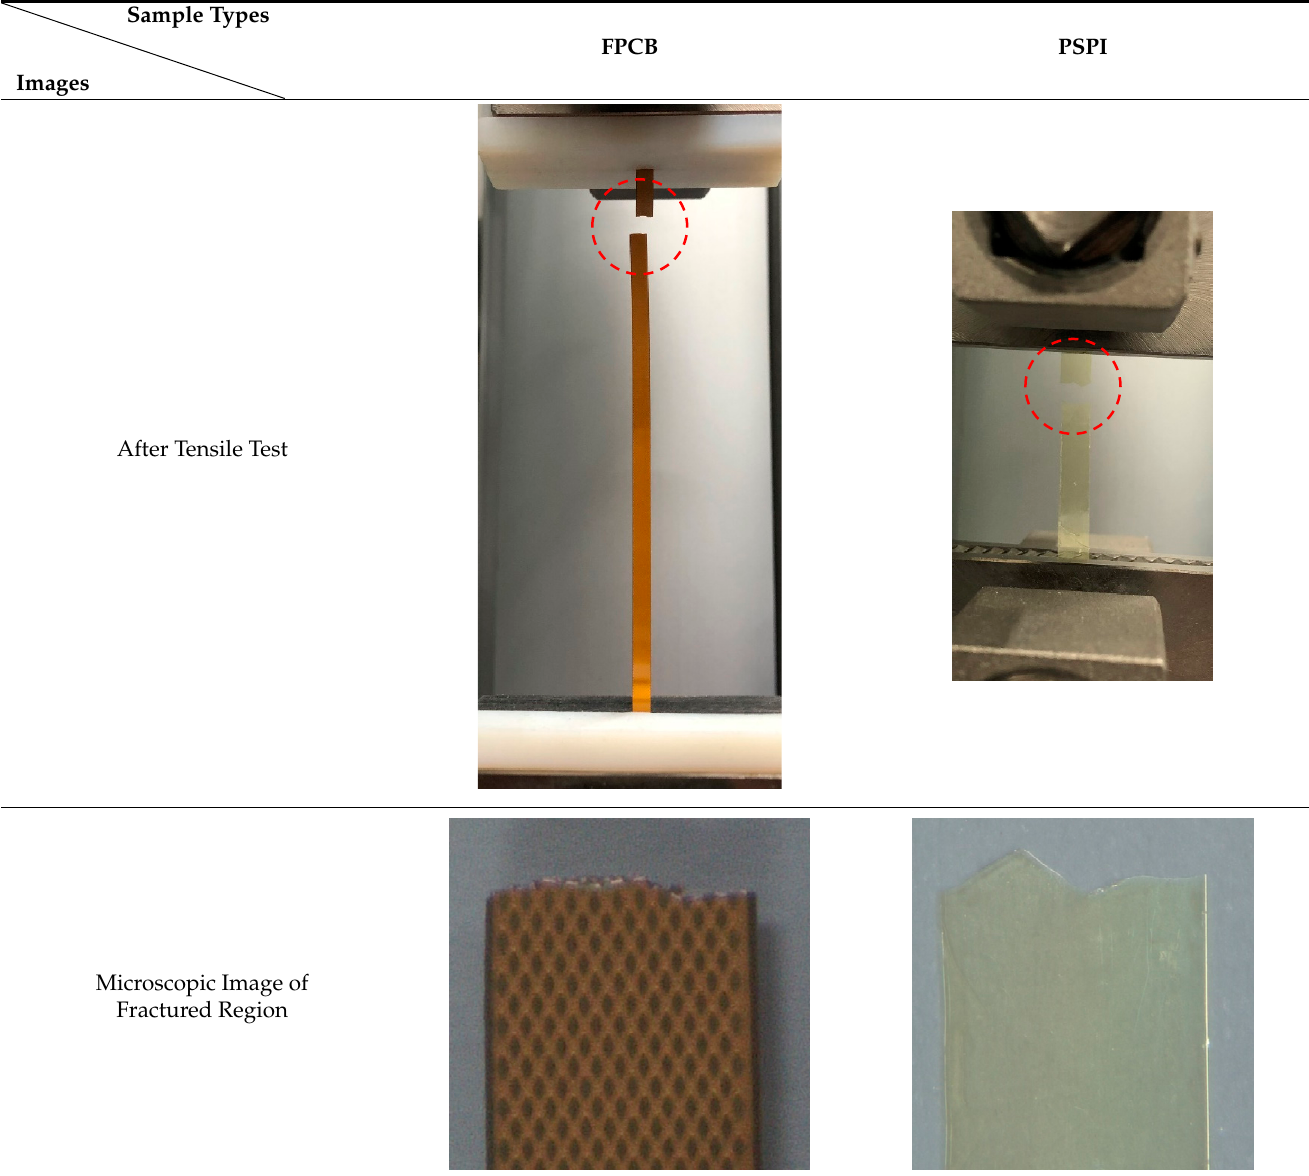
Table 2. Result images of tensile tests with FPCB and PSPI samples.